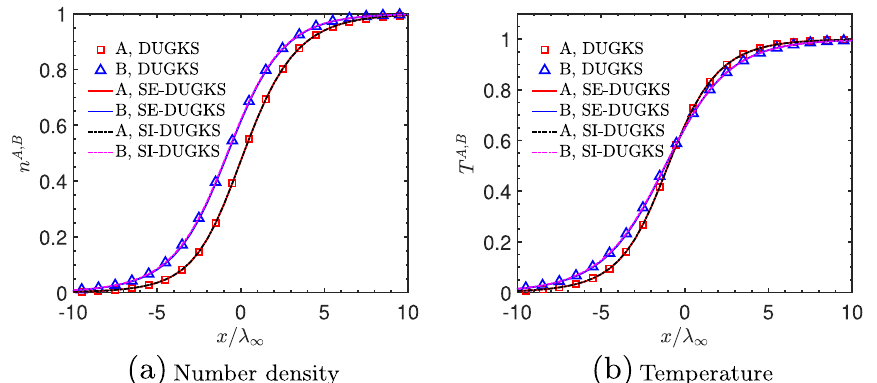
Fig. 5 Shock structure with Ma − = 1.5 , m B ∕ m A = 0.25 , and 𝜒 A = 0.9